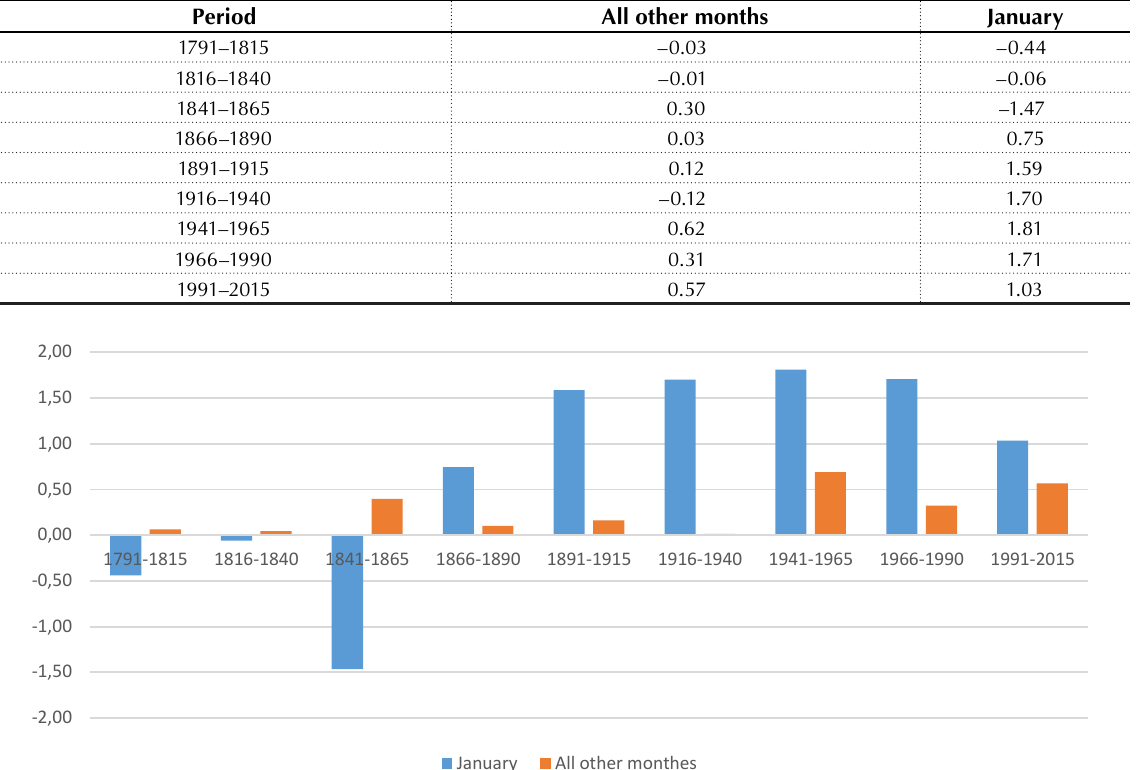
Figure A 1. Average returns by months in the US stock market during